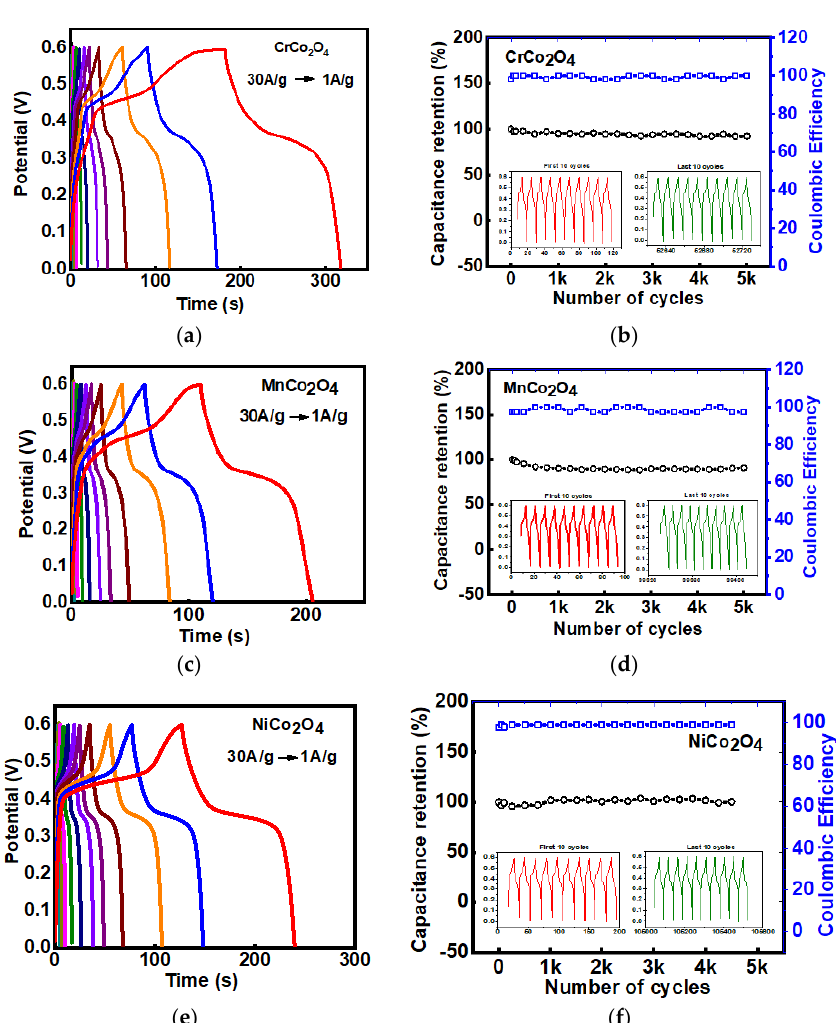
Figure 6. ( a , c , e ) show charge-discharge (CD) curves of tubular MCo 2 O 4 (M = Cr, Mn, Ni) electrode measured in the current density window of 1 to 30 A/g in 3M KOH electrolyte, where red color CD curve is for 1A/g, blue color CD curve is for 1.5A/g, orange color CD curve is for 2A/g and continuously time is decreasing with increasing current density. ( b , d , f ) show cyclic stability (black color) and coulombic efficiency (blue color) tested at 10 A/g current density for 5000 cycles in 3M KOH electrolytes of MCo 2 O 4 (M = Cr, Mn, Ni).